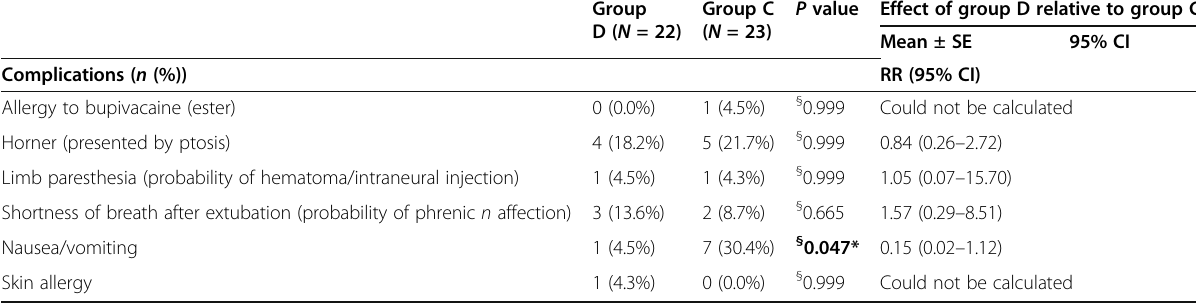
Table 5 Comparing complications in the two